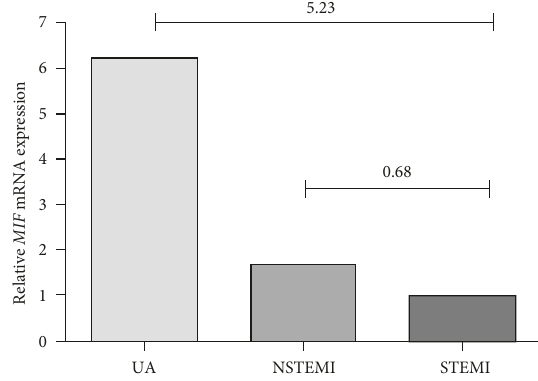
Figure 2: Relative MIF mRNA expression of total leucocytes in the clinical manifestation of ACS. UA and STEMI presented more MIF mRNA expression than NSTEMI (5.23 and 0.68,